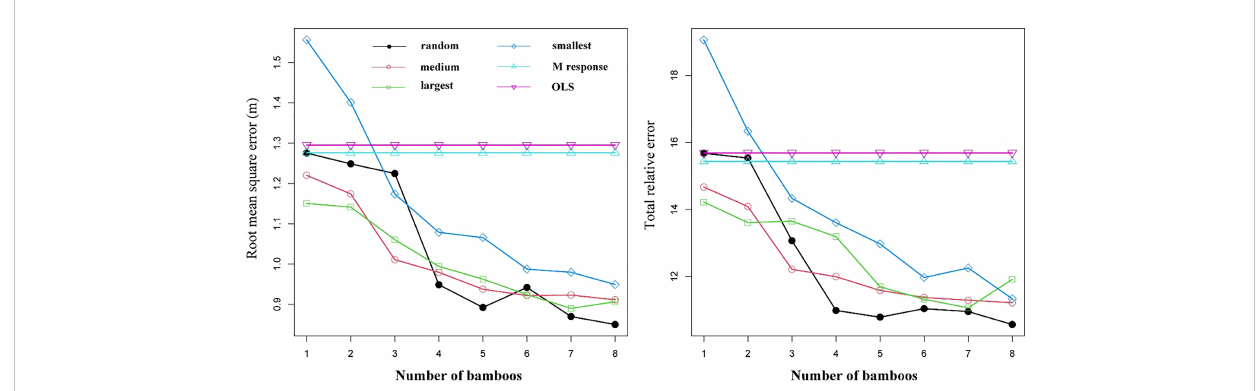
FIGURE 7 Root mean squared error (RMSE) and total relative error (TRE) for the ordinary least square (OLS) model (Eq. 11), mean response of NLME model (M response) (Eq. 12), and NLME model (Eq. 12) calibrated using four sampling